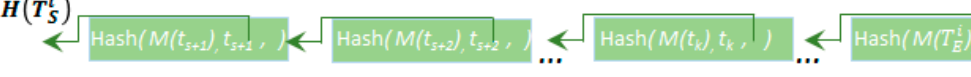
Figure 3. Hashed linked back monitored values.